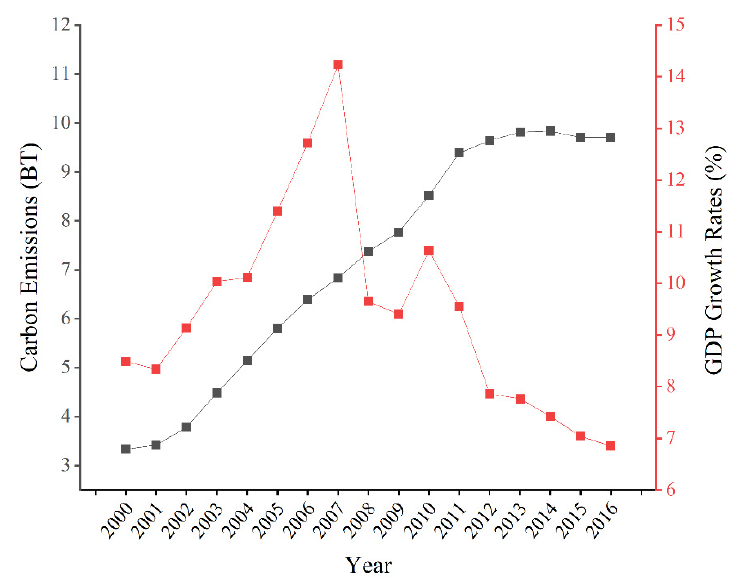
Figure 1. Carbon Emissions and Economic Growth Trends of China.